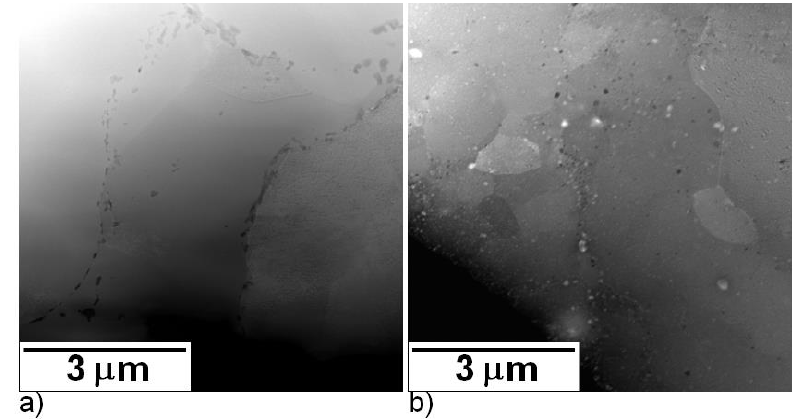
Figure 8. STEM/HAADF micrographs of Fe28Al spark plasma sintering (SPS) compacted at 1100 °C sintered from ( a ) initial powder and ( b ) 1-h milled powder.